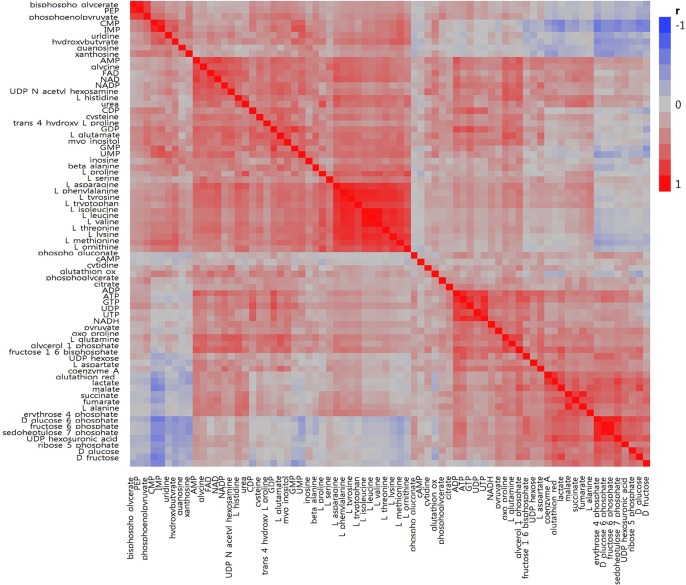
Correlation heatmap for 74 metabolites measured in porcine liver. Within the heatmap, red shows a positive correlation and blue shows a negative correlation.